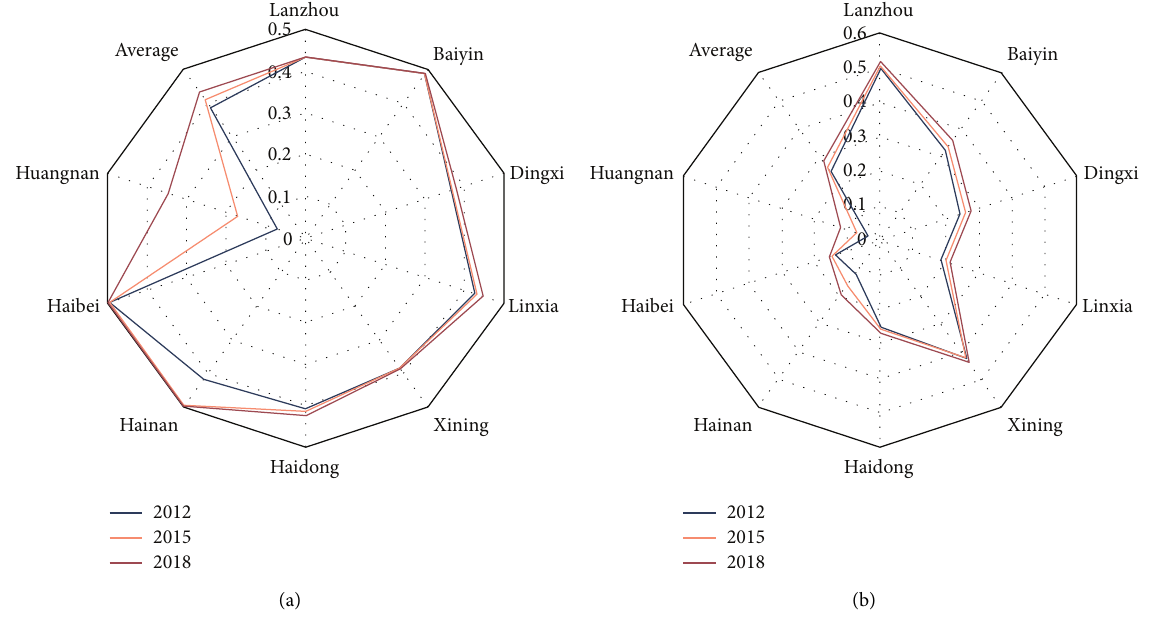
Figure 6: The degree of coupling and coordination between UCI and HDI in Lanzhou-Xining urban agglomeration. (a) Coupling degree and (b) coordination